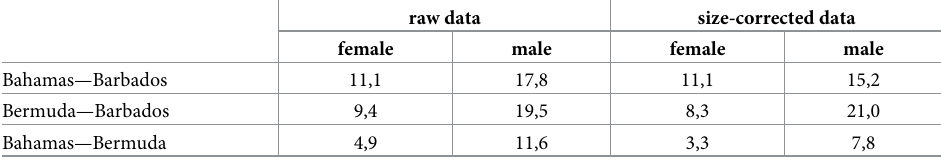
Table 2. Squared Mahalanobis distances (D 2 ) between the populations in raw and size-corrected data of females and males, respectively.